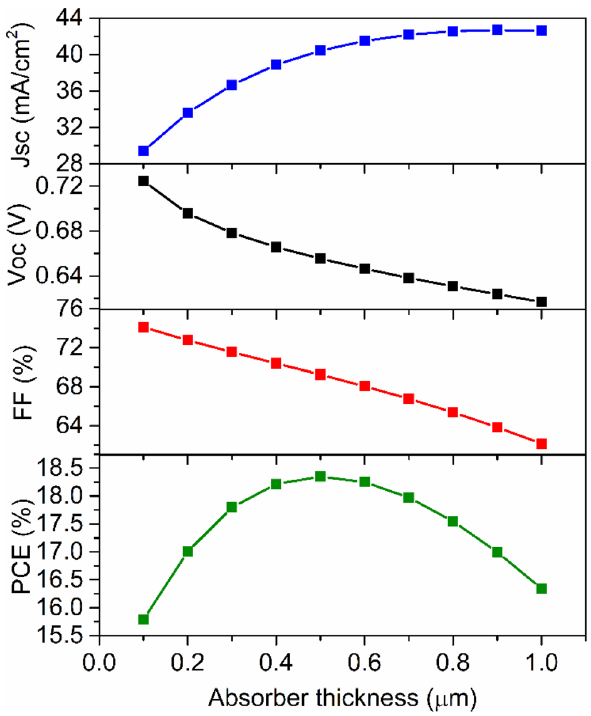
Figure 3. Photovoltaic response as a function of absorber layer thickness.